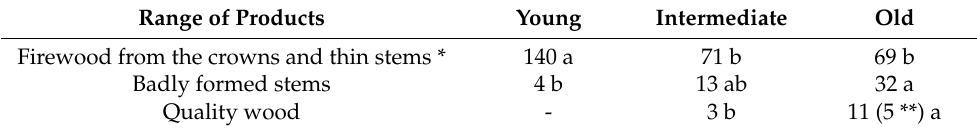
Figure 5. Number of stems to extract and to remain in the thinning simulation per diameter class. Left : young, centre : intermediate, and right : old stands; the ordinates are differently scaled because otherwise, the charts with low number of stems/ha (intermediate and old stands) would not be readable.